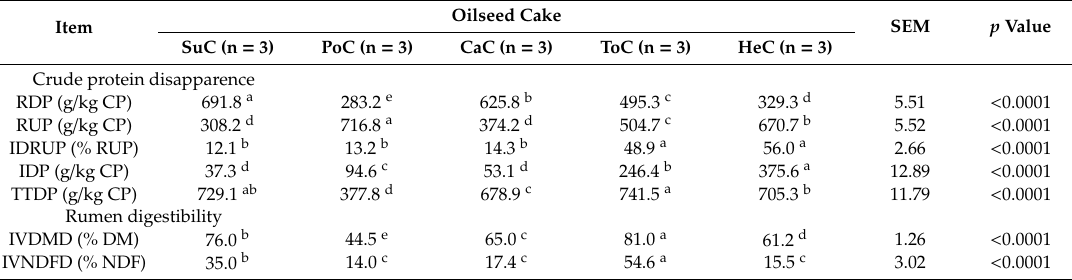
Table 3. In vitro digestibility of crude protein, dry matter, neutral detergent fiber (LSM) of the oilseed